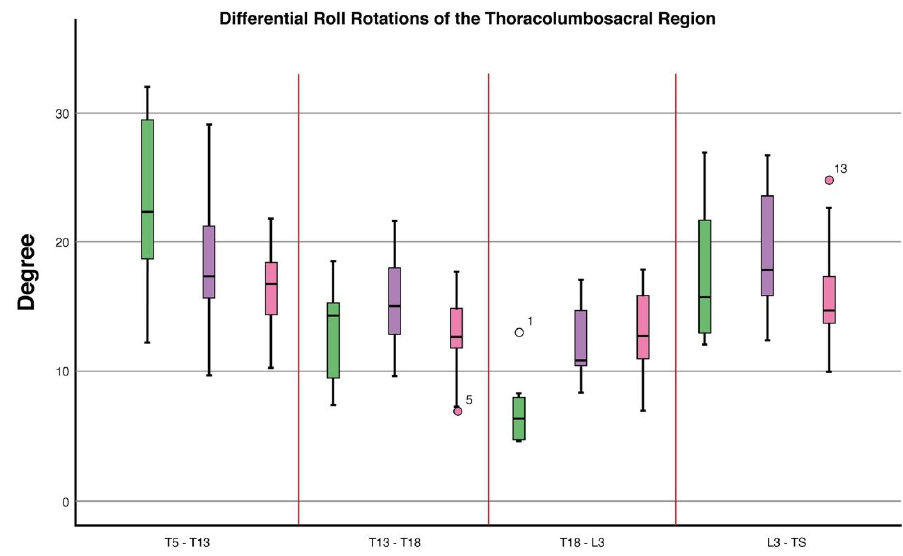
Figure 5. Boxplots displaying differential roll rotations of the thoracolumbosacral spine in 10 dressage horses whilst trotting in-hand and when being ridden in sitting trot and canter. At T5-T13, differential roll rotations differed between conditions ( p = 0.04) where a decrease in differential roll rotations when in canter compared to trotting in-hand ( p = 0.005) was found. At L3-TS, differential roll rotations differed between conditions ( p = 0.05); however, no differences were found between conditions in post hoc analysis. Explanation of symbols: the central line represents the median; the box represents the 25th and 75th percentiles; the whiskers represent the maxima and minima not considered to be outliers; ° represents outliers. Boxplot ID: green = in-hand trot, purple = sitting trot and pink = canter.